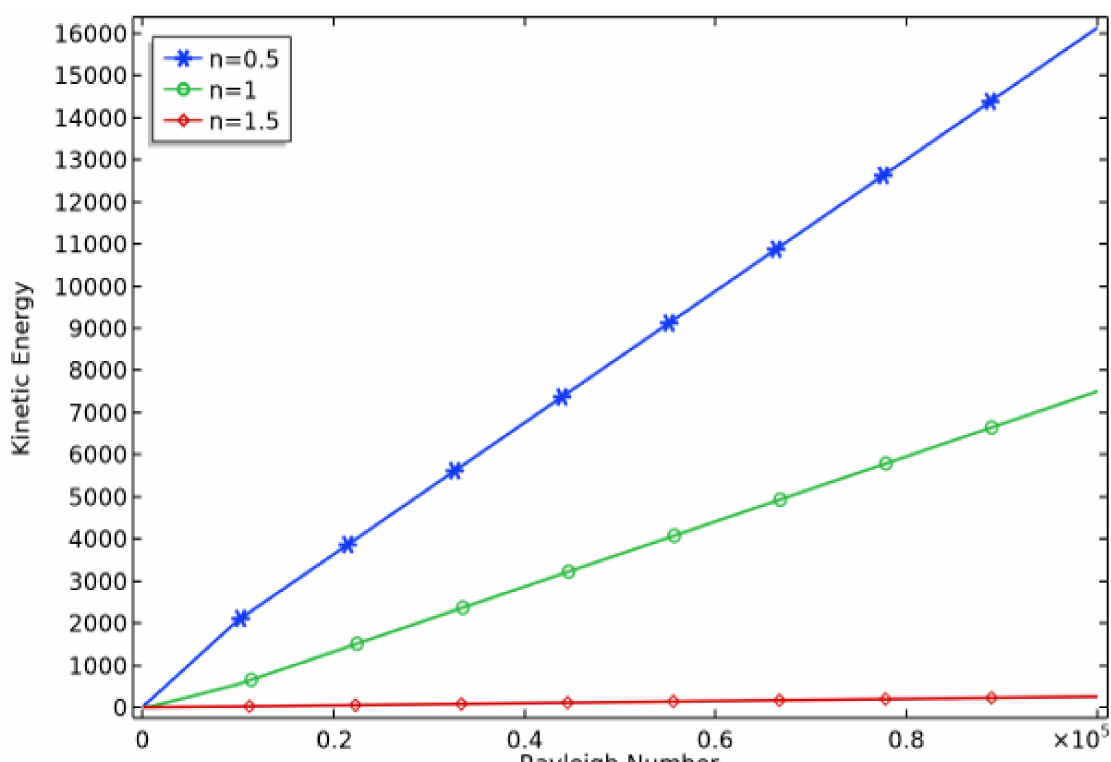
Figure 10. Variation in kinetic energy against ( Ra ) and ( n ) at X =